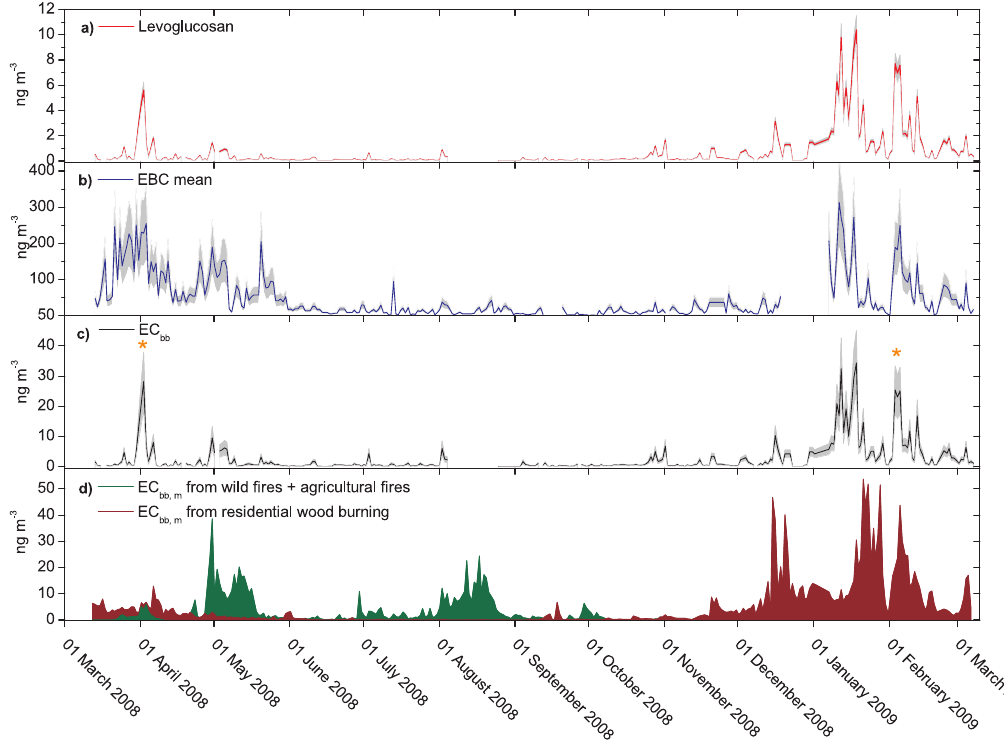
Figure 2. Ambient aerosol concentrations of levoglucosan (a) , equivalent black carbon (EBC) (b) and elemental carbon from biomass burning (EC bb ) (c) , presented as 24h mean concentrations for the Zeppelin observatory during the period 12 March 2008–7 March 2009. (d) shows modeled concentrations of EC bb (EC bb,m ), as obtained by the FLEXPART model. The green curve is the sum of EC from wildfires and agricultural fires, whereas the red curve is EC from residential wood burning. The two orange asterisks in (c) indicate episodes with a rapid increase in the EC bb concentration that are not captured well by the model and which are discussed in further detail in Sect.